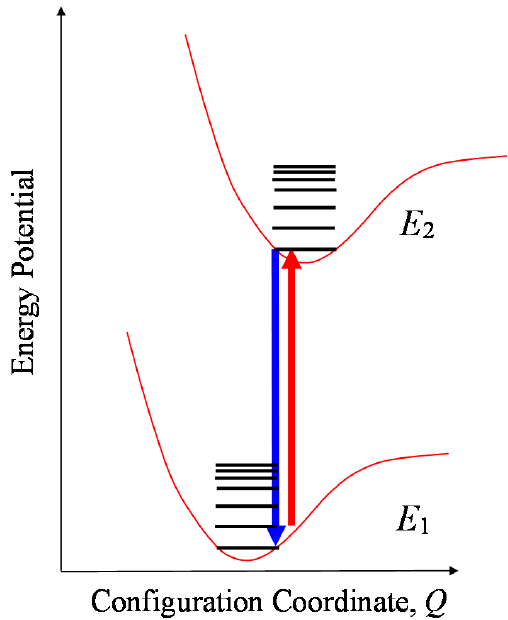
Figure 5. Quantized anti-Stokes luminescence in a 2-level system with electric-dipole-allowed transitions between ground and excited state vibrational sub-levels. The red arrow is a v = 1 to v’ = 0 absorption transition. The blue arrow is a v’ = 0 to v = 0 emission transition that contributes to cooling by avoiding configuration relaxation.